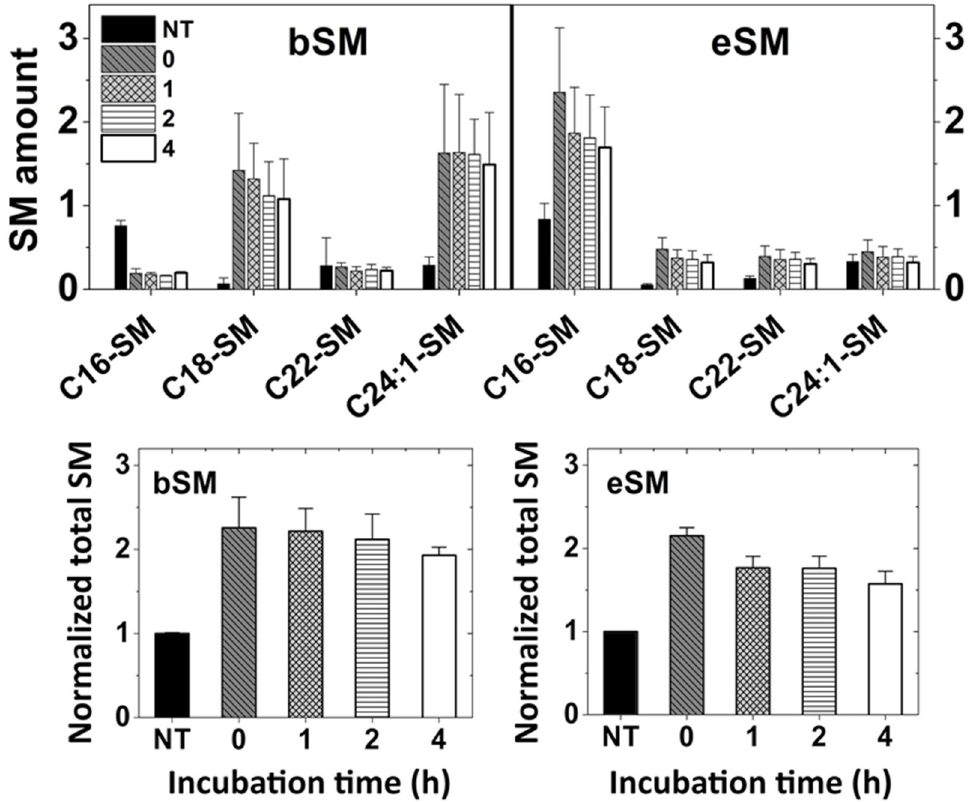
(right panel). (SM amount shown in (pmole x 10 4 )/mg protein)). B. Total SM levels after exchange with bSM (left panel) or eSM (right panel). SM levels shown relative to that in untreated cells. NT = untreated cell control. Exchange